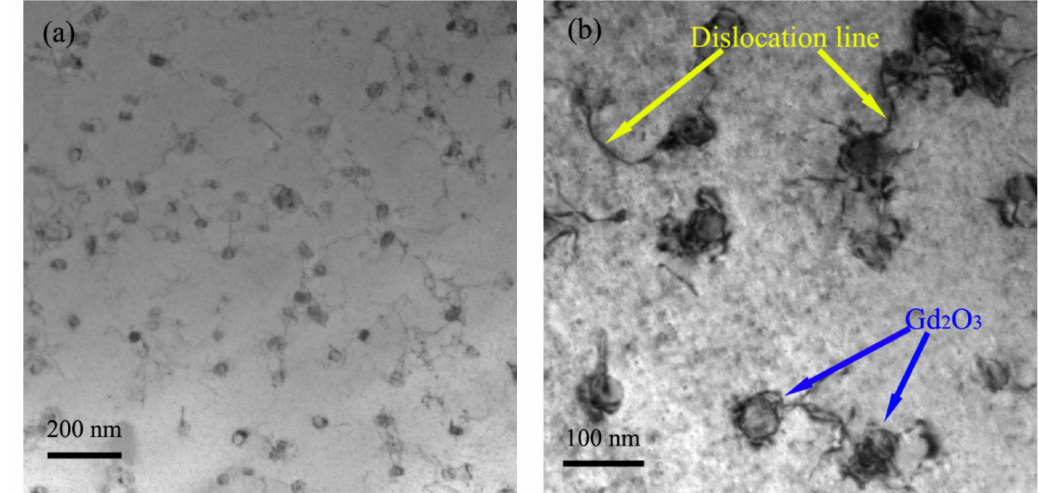
Figure 9. Dislocation line trapped by nano-Gd 2 O 3 particles ( a ) TEM image at lower magnification; ( b ) TEM image at higher